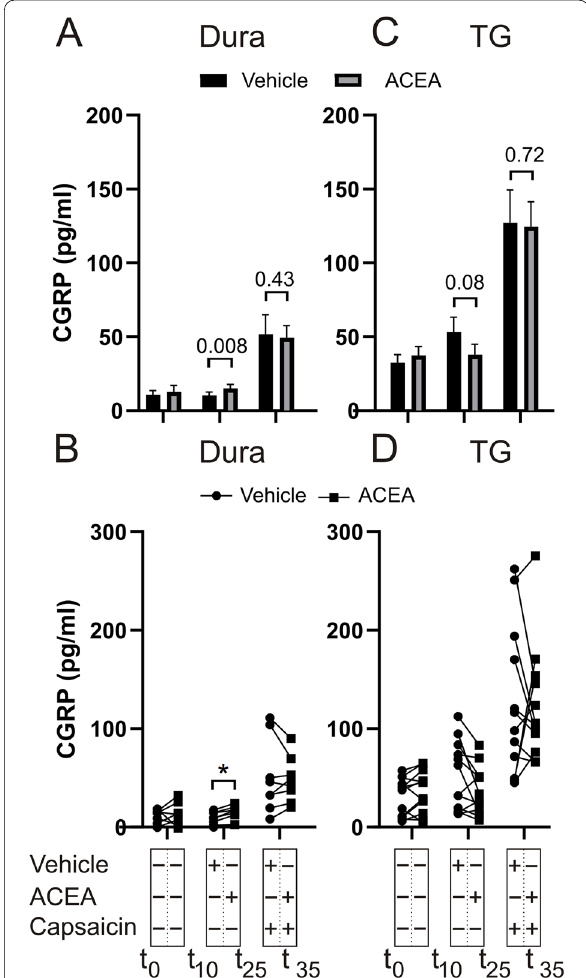
Fig. 1 Effects of ACEA on capsaicin-induced CGRP release from dura and TG. Application of 140 nM ACEA caused a significant increase Fig. 2 Effects of ACEA on K + -induced CGRP release from dura and in CGRP release from the dura ( n 8). 100 nM capsaicin caused a = TG. A Application of 140 nM ACEA did not cause a significant increase significant increase in CGRP release, which was not attenuated by in CGRP release from the dura ( n 12). KCl (60 mM K + ) caused a the presence of ACEA. B Graphical illustration of the sample pairing. = significant increase in CGRP release, which was not attenuated C Application of 140 nM ACEA had no effect on the CGRP release by the presence of ACEA. B Graphical illustration of the sample from the TG per se, nor on the release induced by 100 nM capsaicin pairing. C Application of 140 nM ACEA had no effect on the CGRP ( n 12). D Graphical illustration of the sample pairing. B baseline. = = release from the TG per se, nor on the release induced by 60 mM K + Timeline in minutes are added on the lower panel. Data are shown ( n 12). D Graphical illustration of the sample pairing. B baseline. as mean SEM or their individual data points with pairing, and with = = ± Timeline in minutes are added on the lower panel. Data are shown p values obtained with Student’s T-test being depicted in the graph as mean SEM or their individual data points with pairing, and with (* p < 0.05). For reference 100 pg/ml equals 26.4 pmol/l ± = p values obtained with Student’s T-test being depicted in the graph (* p < 0.05). For reference 100 pg/ml equals 26.4 = 60 mM K + was used as depolarizing stimulus. Addition in these experiments, we combined all data after add- of 140 nM ACEA per se showed a slight but similar ten- ing ACEA and compared to vehicle. The direct effect dency to stimulate CGRP release in the dura (w/o ACEA: of adding ACEA per se was a change from baseline of 4.1 1.9 pg/mL compared to vehicle at 0.7 1.7 pg/ ± − ± mL being significant ( p 0.023, n 20). When we fur- = = ther tested whether the addition of 140 nM ACEA would